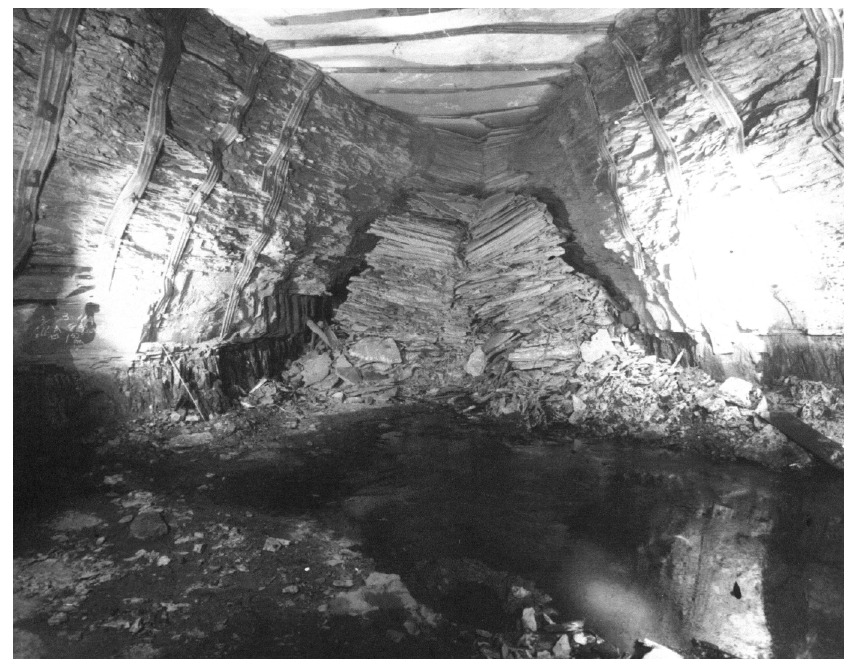
Figure 1. Collapse of immediate roof due to increased horizontal stresses in the Beckley mine [7].